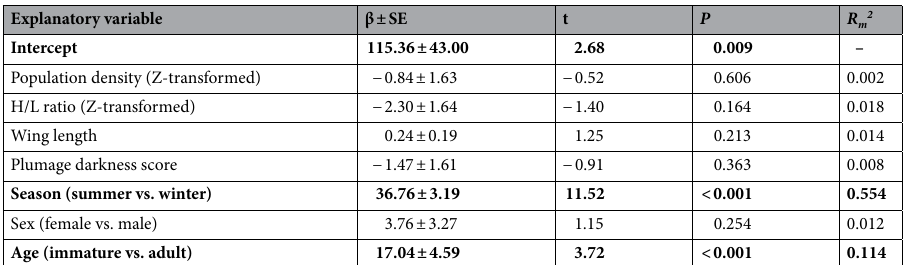
Table 2. The effects of population density, physiological stress (heterophil/lymphocyte ratio, H/L ratio), body size (wing length), plumage darkness score, season, sex and age on blood haemoglobin concentration, as assessed with generalized linear mixed model fitted with Restricted Maximum Likelihood (REML). The plot identity was used as the random factor. The semi-partial R m2 represents the percentage of variance explained by each predictor. Significant predictors are marked in